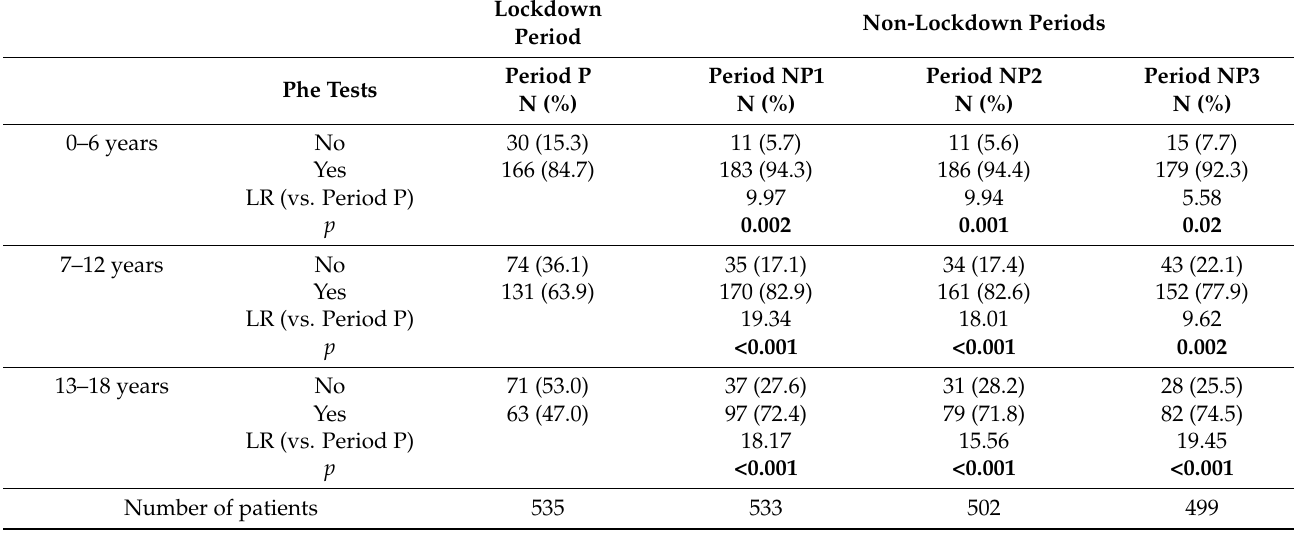
Table 3. The number of patients who did/did not perform phenylalanine tests in the compared time intervals (periods P and NP1 to NP3).